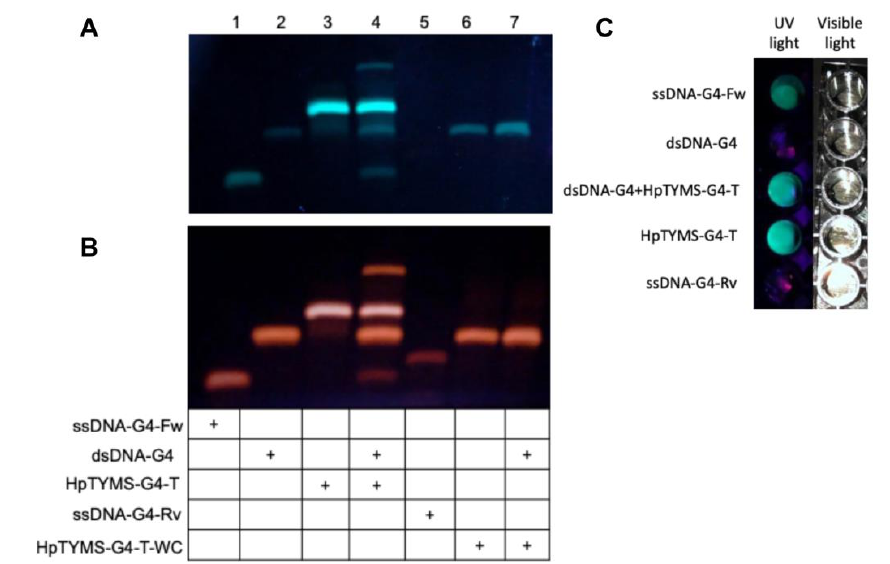
Figure 5. DNA binding assays and G4 structure detection using ThT. Samples incubated at 90°C were cooled down slowly to room temperature and loaded in a nondenaturing 12% acrylamide gel supplemented with 10mM KCl. The gel was visualized under UV light after ThT staining (A) and EthBr staining. (B) Lane 1, ssDNA-G4-Fw alone; lane 2, dsDNA-G4 alone; lane 3, HpTYMS-G4-T alone; lane 4, dsDNA-G4-2 plus HpTYMS-G4-T; lane 5, ssDNA-G4-Rv alone; lane 6, HpTYMS-G4-T- WC alone; lane 7, dsDNA-G4 plus HpTYMS-G4-T-WC. (C) G4 detection in samples directly incubated with ThT and visualized under UV light. Samples were prepared as indicated in Section 4.11 of Materials and Methods but containing 1 μM of each oligonucleotide. When samples reached room temp erature, 8 μM of ThT was added and samples were visualized under UV light lamp or visible light.